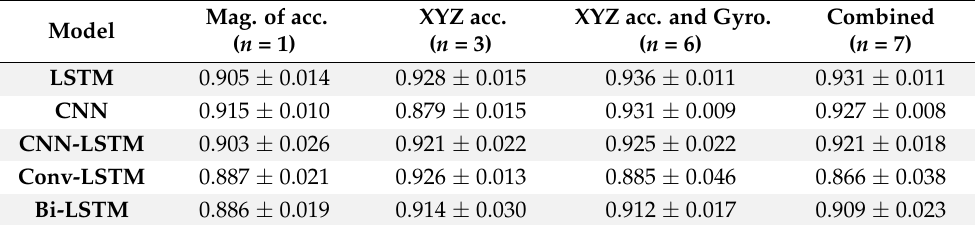
Table 3. The average 10-fold cross-validation accuracy of LSTM, CNN-1D, CNN-LSTM, Conv- LSTM-1D, and Bi-LSTM on four different input datasets from the young adult chest data on five human